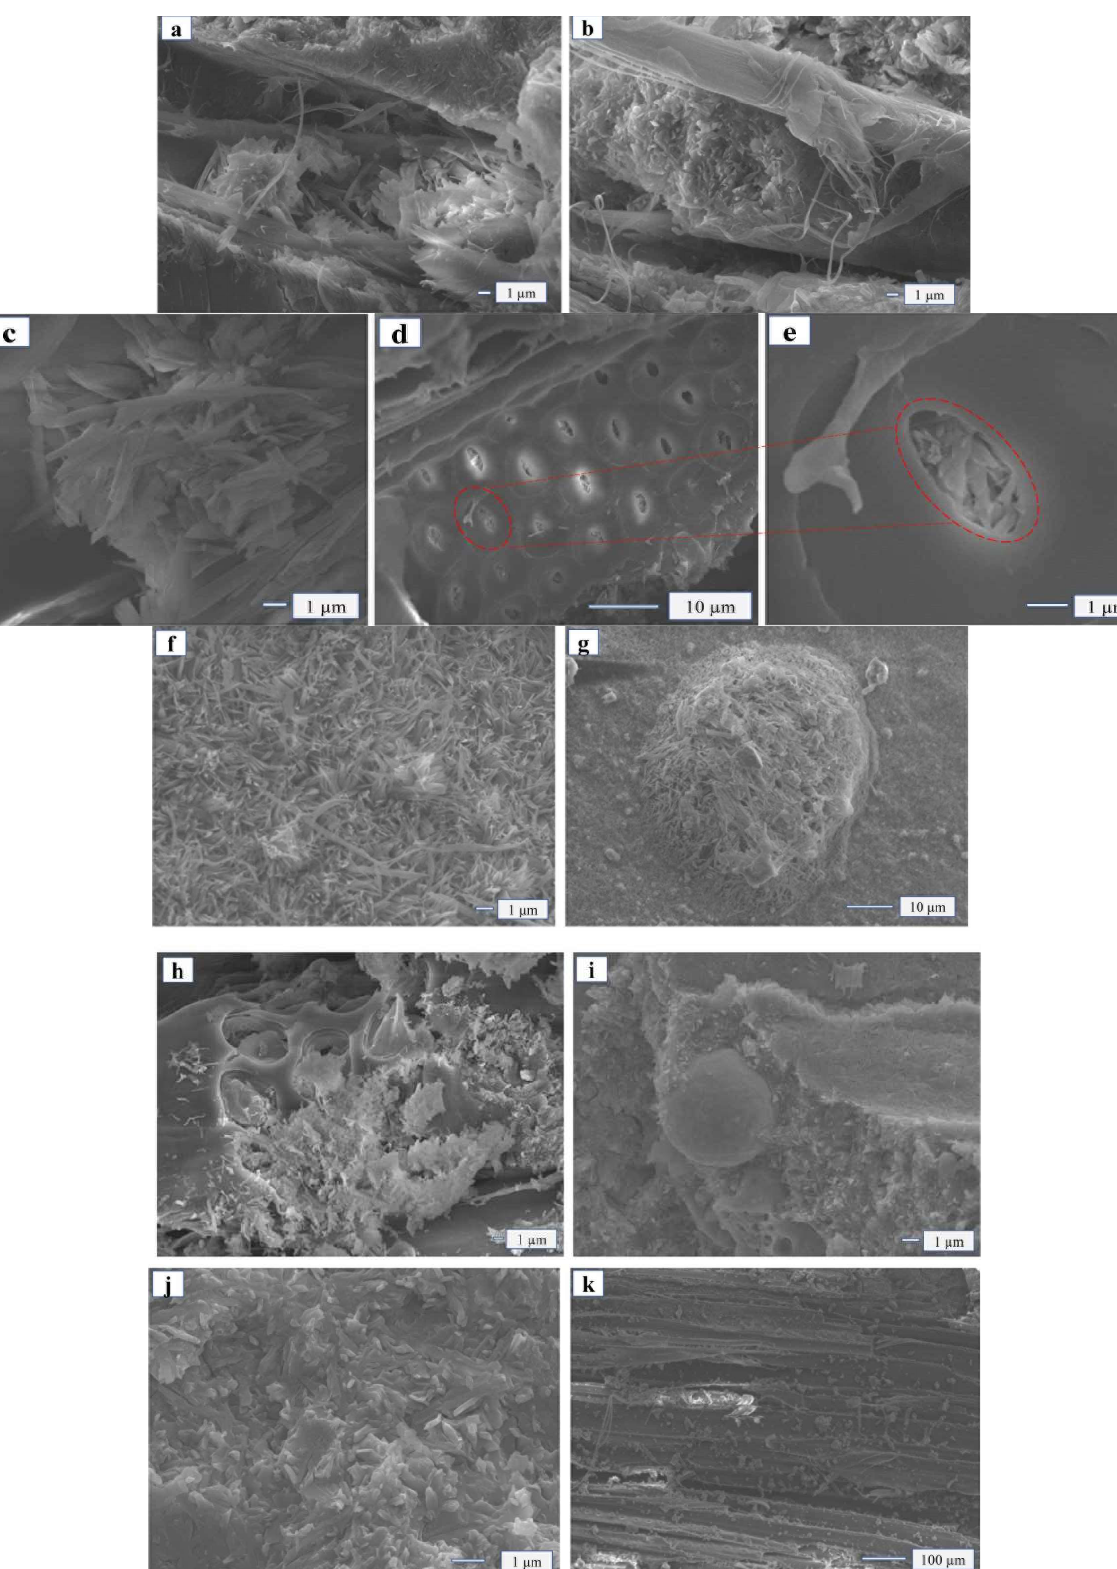
Figure 5. SEM of MOPB-FA with different FA additions. ( a , b ) 5 wt%; ( c – e ) 15 wt%; ( f , g ) 20 wt%; ( h , i ) 25 wt%; ( j , k ) 35 wt%.